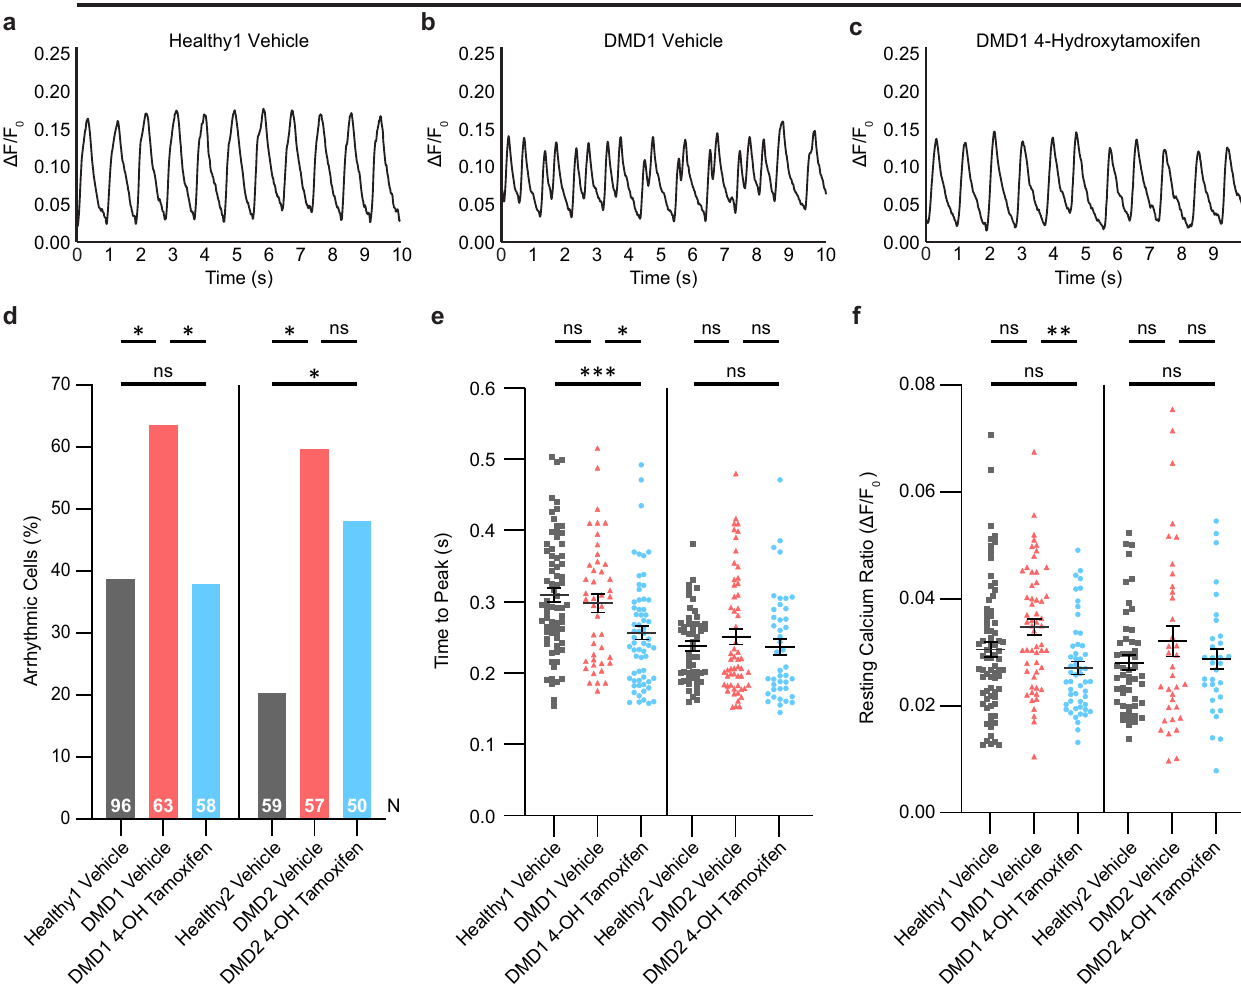
bene fi cial to the DMD heart.